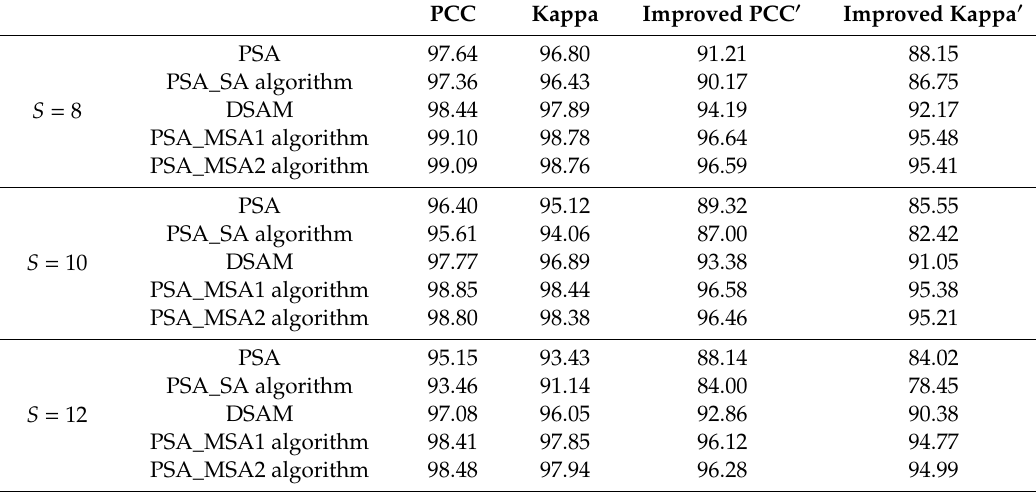
Table 2. Accuracy results (%) from different models for an artificial land image.